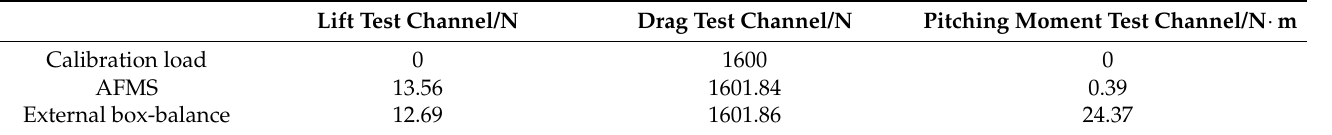
Figure 1. Three-dimensional model diagram of force measuring support. (a) The 3D model of AFMS. (b) The force measuring elements in AFMS. (c) The convex platforms in the joint of AFMS.